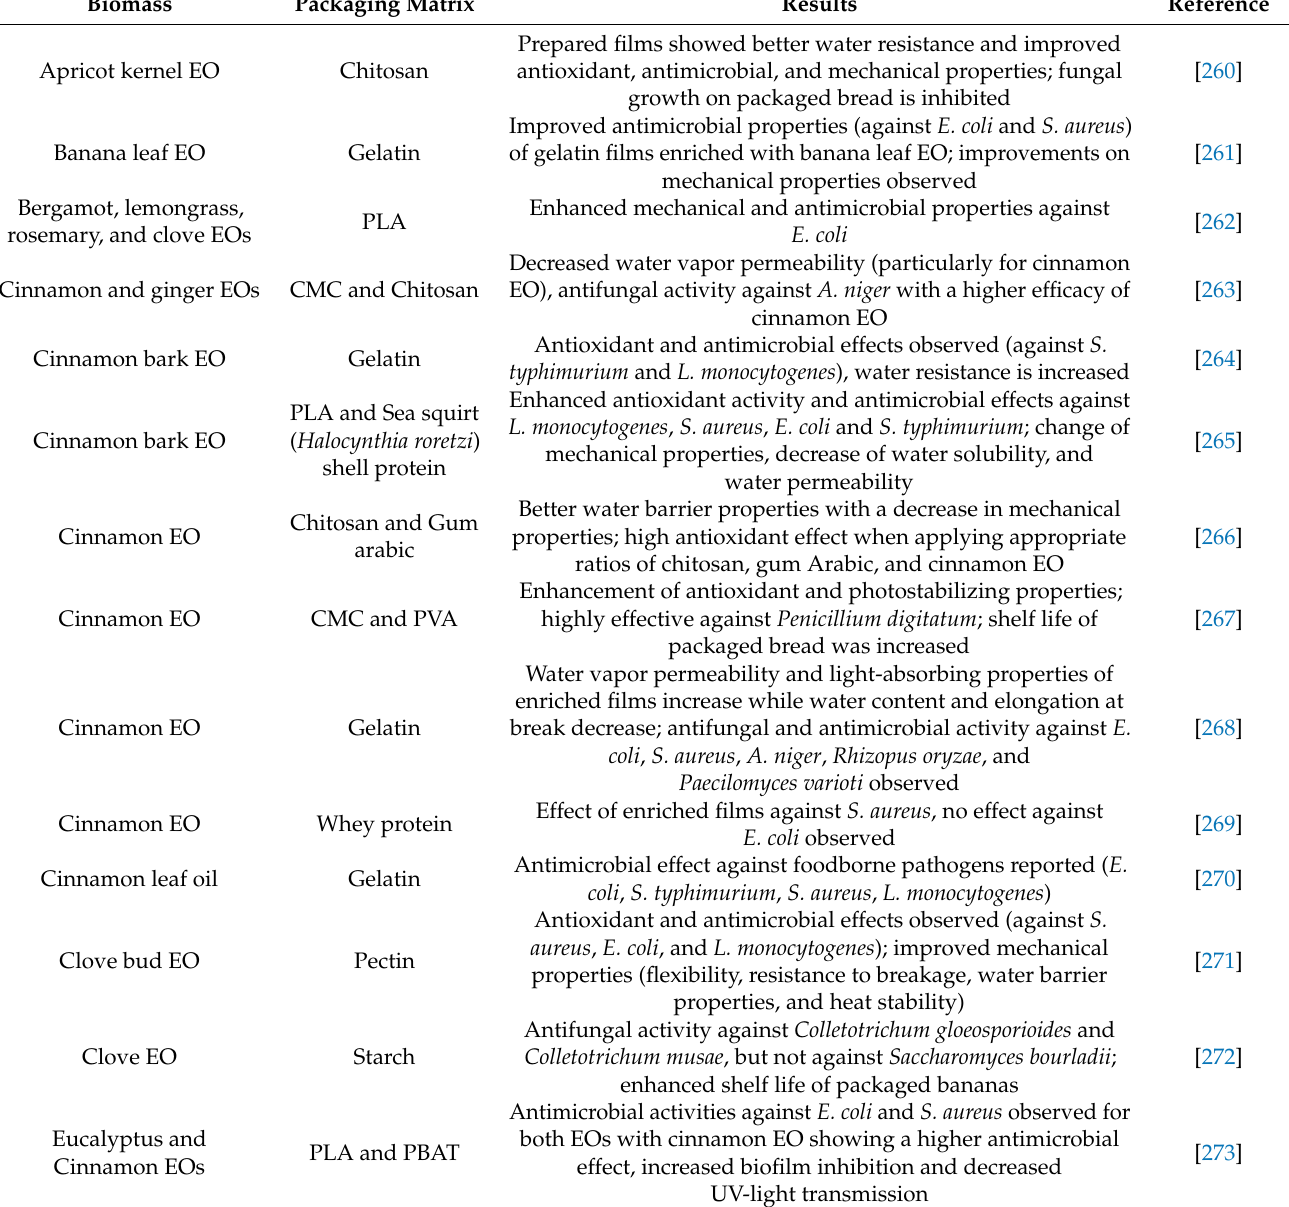
Table 6. Spotlight literature for plant essential oils used in the context of active food